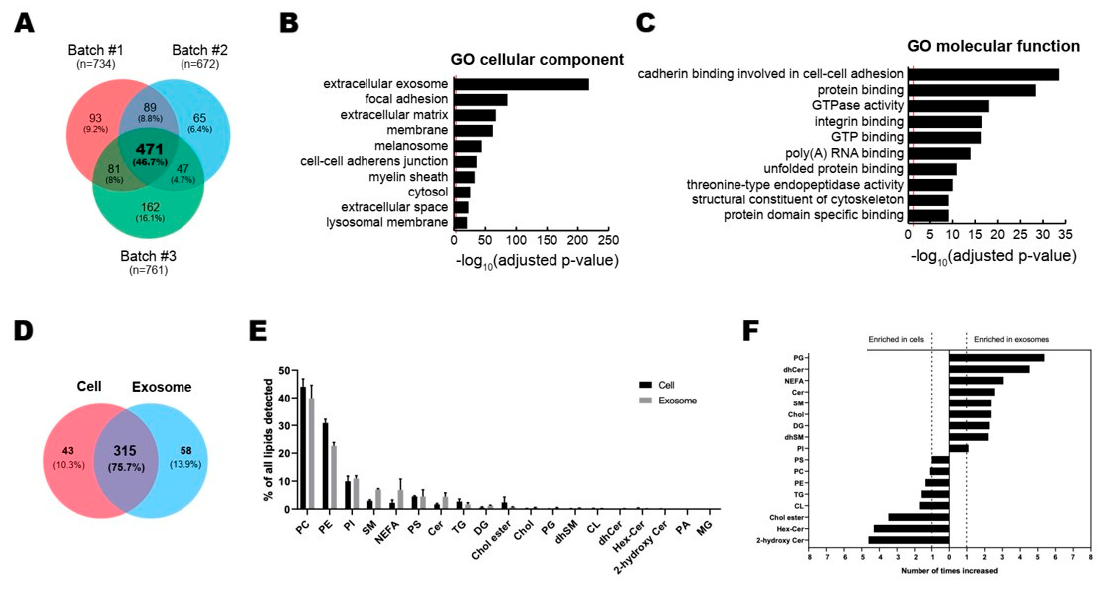
Figure 2. Multi-layer omics analysis of ASC-exosomes. ( A – C ) Proteomic analysis of ASC-exosomes by LC-MS / MS in three independent batches of ASC-exosomes. ( A ) Venn diagram showing the number of exosomal proteins that were either unique or overlapping in each indicated batch. ( B , C ) Gene Ontology (GO) analysis of 471 commonly found exosomal proteins. Enrichment of GO molecular function and cellular component performed using DAVID Bioinformatics resources 6.8. Vertical red lines represent the cuto ff for significance of -log10( p -value) with Benjamini-Hochberg correction. ( D–F ) Lipidomics of ASC-exosomes. ( D ) Lipid composition of ASC-exosomes and their originating cells. A-Venn diagram showing the number of species quantified in this study. ( E ) Lipid classes detected in ASCs and ASC-exosomes. ( F ) Enrichment of lipid classes in ASCs or ASC-exosomes calculated as mol% of lipids in these samples. PC: phosphatidylcholine, PE: phosphatidylethanolamine, PI: phosphatidylinositol, SM: sphingomyelin, NEFA: non esterified fatty acid, PS: phosphatidylserine, CER: ceramide, TG: triacylglycerol, DG: Diacylglycerol, Chol ester: cholesterol ester, Chol: Cholesterol, PG: phosphatidylglycerol, dhSM: dihydrosphingomyelin, CL: cardiolipin, dhCER: dihydroceramide, Hex-Cer: hexosylceramides, PA: phosphatidic acid, MG: monoradylglycer.